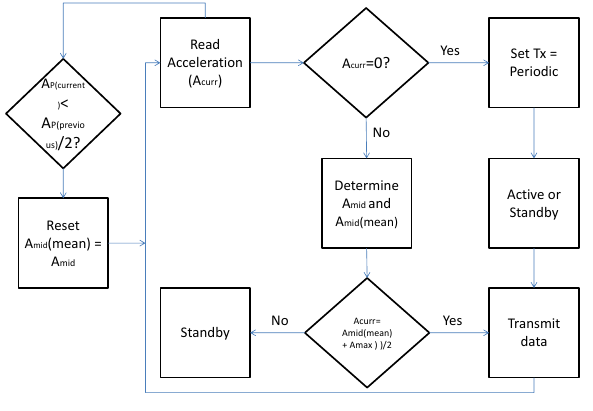
Figure 1: The A-MAC Flowchart to duty cycle the node’s